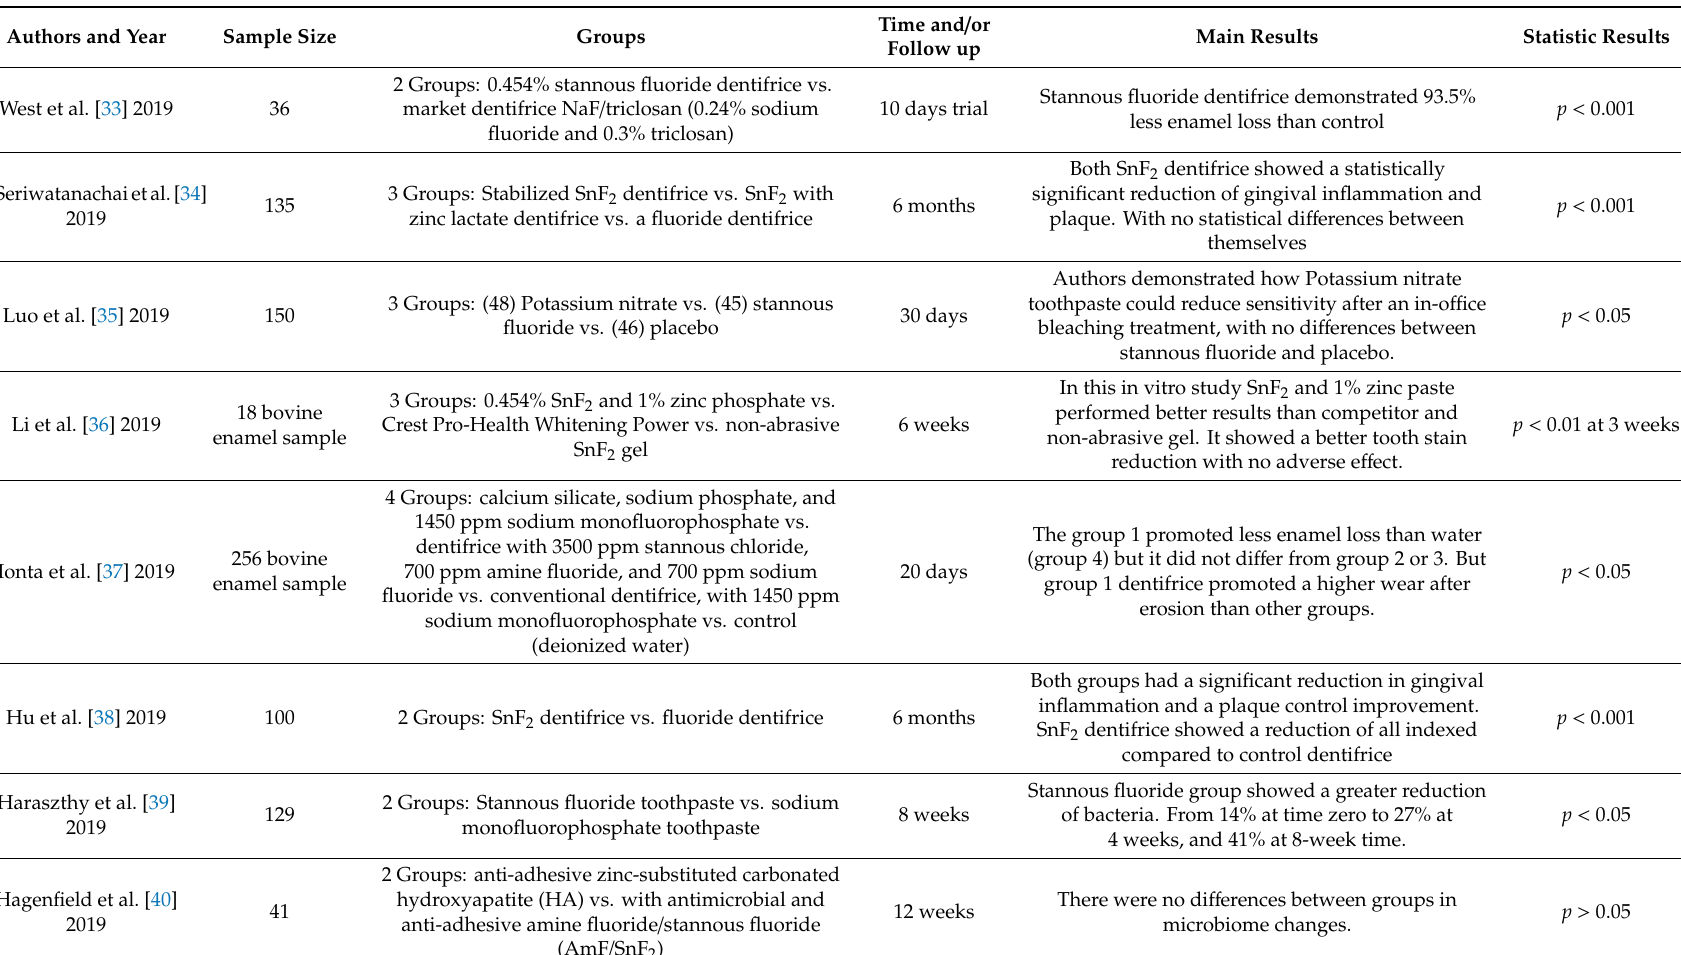
Table 1. Results of individual studies table. This table shows results according to paragraph summary